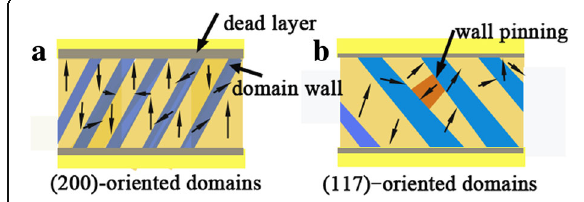
Fig. 6. a , b Schematic domain structure in the a – b plane of the (200)-oriented and (117)-oriented BNTM thin films (the domain orientation can trace the